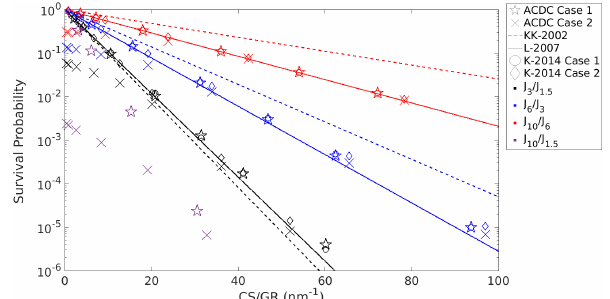
Figure 5. Survival probabilities from 1.5 to 3nm ( J 3 /J 1 . 5 ), from 3 to 6nm ( J 6 /J 3 ), from 6 to 10nm ( J 10 /J 6 ), and from 1.5 to 10nm ( J 10 /J 1 . 5 ). Horizontal axis is expressed in terms of back- ground condensation sink of sulfuric acid (CS) and the mean growth rate (GR) in the size range. Survival probabilities based on Atmo- spheric Cluster Dynamics Code (ACDC) simulation results and the- oretical predictions are included. The ACDC survival probabilities are divided into two different cases: in Case 1 no collisions be- tween clusters occur and in Case 2 collisions between clusters are also allowed to occur. In both Cases 1 and 2, monomer concentra- tion is C mon = 1 × 10 7 cm − 3 . GR is based on multi-degree poly- nomial regression. The theoretical predictions are based on Ker- minen and Kulmala (2002) (KK-2002) and Lehtinen et al. (2007) (L-2007) formulations, which assume constant GR, and on Korho- nen et al. (2014) (K-20014) formulation, assuming a power-law size dependency of the GR (see Eqs. 1 and